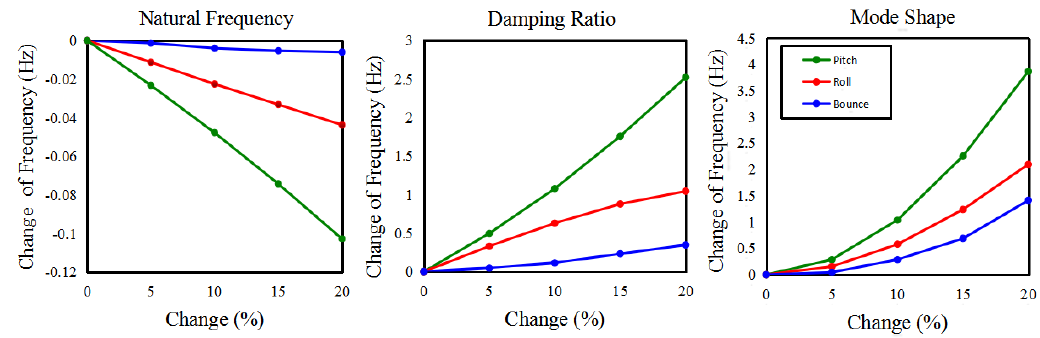
Figure 8. Changes in natural frequency, damping ratio and mode shape caused by a left front spring fault.